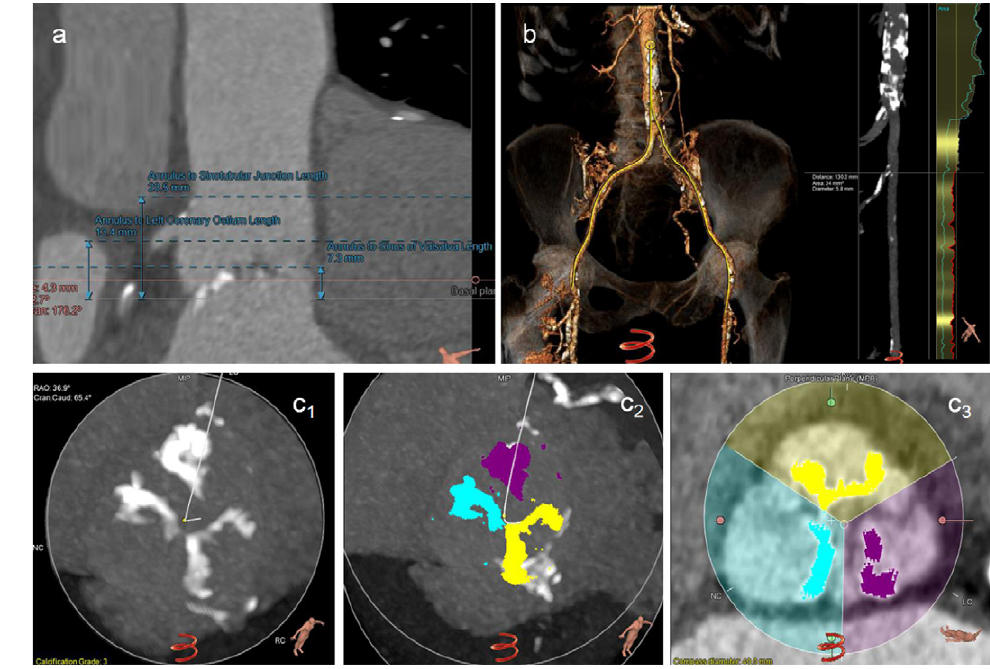
Figure. 5 T-AVI planning with 3Mensio software. (a) distance between coronary ostia, basal plane, sinuses of Valsalva.(b)clearwidthofiliacarteryisvisualizedfortransfemoralaccess.(c)Rosenhekclassificationofvalvular